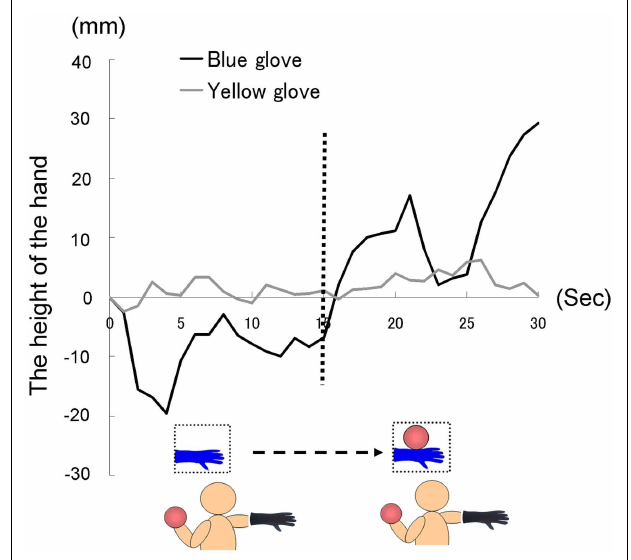
FIGURE 9 |Time course of the height of the hand in each group in Experiment